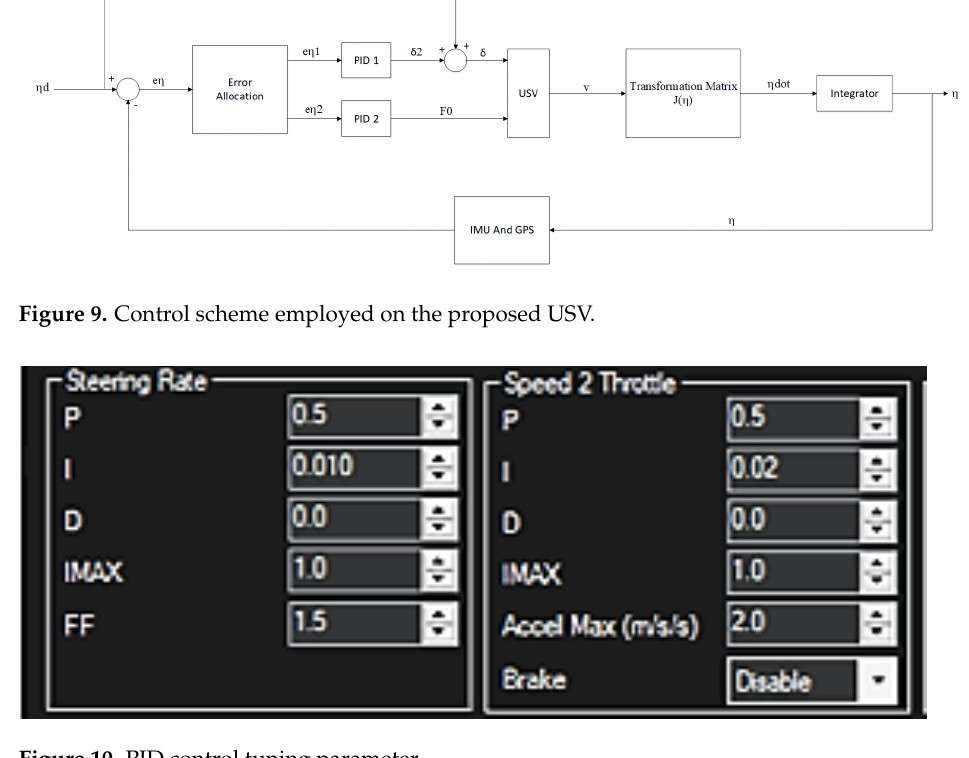
Figure 10. PID control tuning parameter.